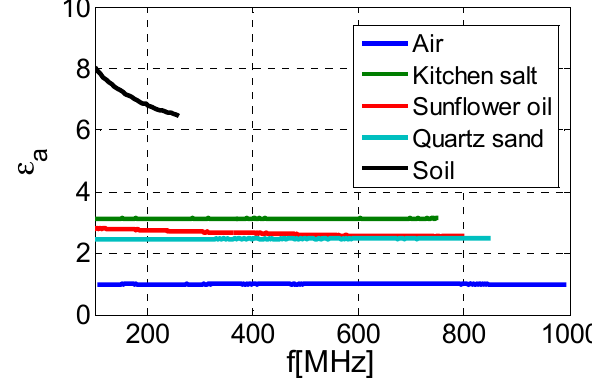
Figure 8. Measured permittivity of various samples, illustrating that the proposed device can be used to estimate permittivity independently of the type of material under